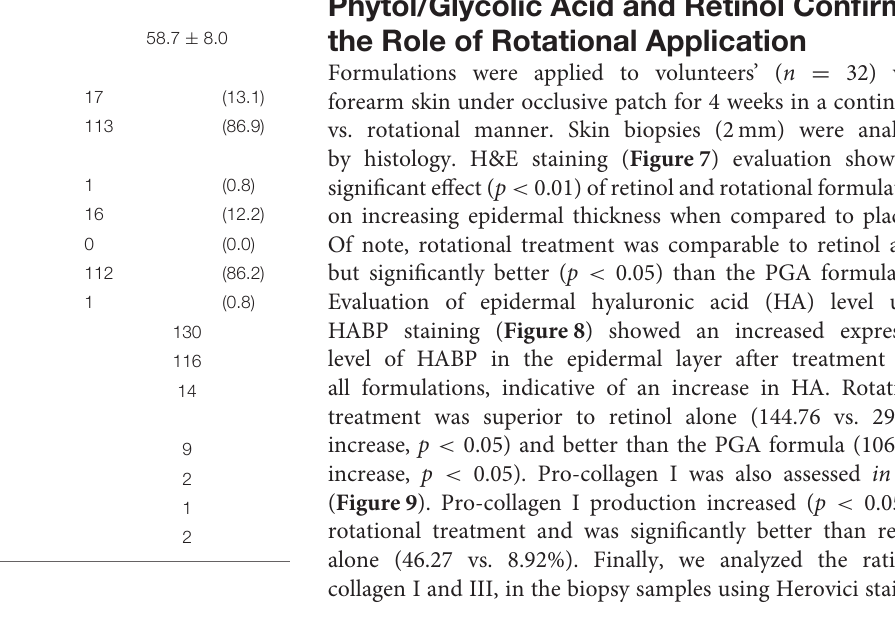
Frontiers in Medicine |